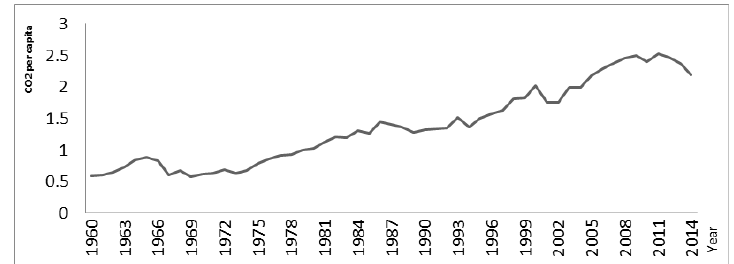
Figure 1. Carbon Dioxide emission per capita in Egypt Source:World Bank (2018)